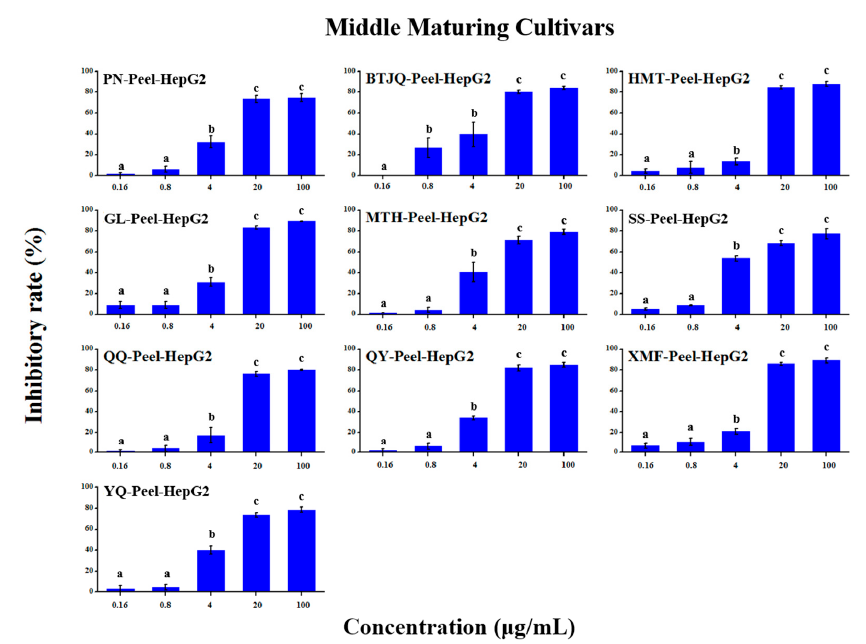
Figure 4. HepG2 growth inhibition effect of peel extracts from middle maturing cultivars.The names of apple cultivars were showed as abbreviations: PN for ‘Poland No.8’, SS for ‘Sourthern Snap’, QQ for ‘Qianqiu’, GL for ‘Gala’, HMT for ‘Hermhut’, XMF for ‘Ximengfei’, BTJQ for ‘ST’, YQ for ‘Yingqiu’, MTH for ‘Mantanghong’, QY for ‘Qiuying’. Different lowercase letters above the bars indicated significant differences at the 0.05 probability level by Tukey test.